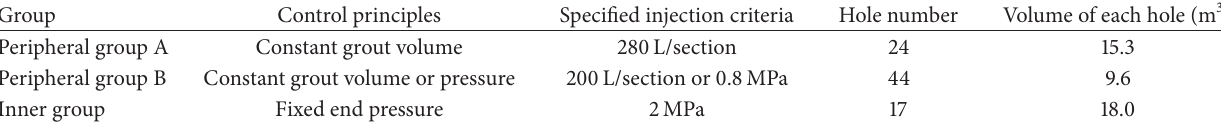
Table 3: Grouting overview for 3 groups.